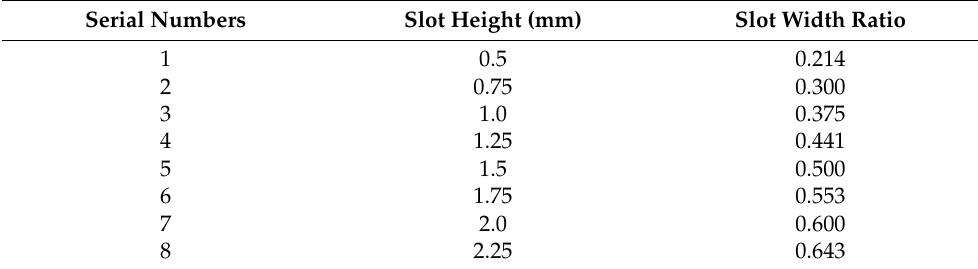
Table 3. Structure parameter of micro-combustors with different slot width ratios.